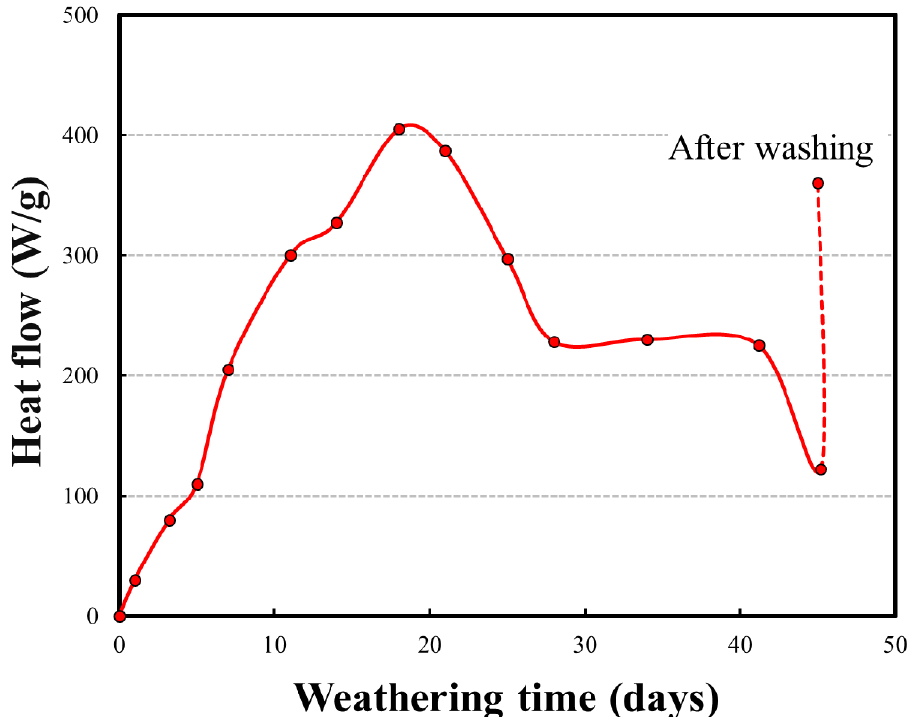
Figure 3. Change in DSC exotherm as a function of extended weathering time (adapted from Rosenblum and Spira [18]).